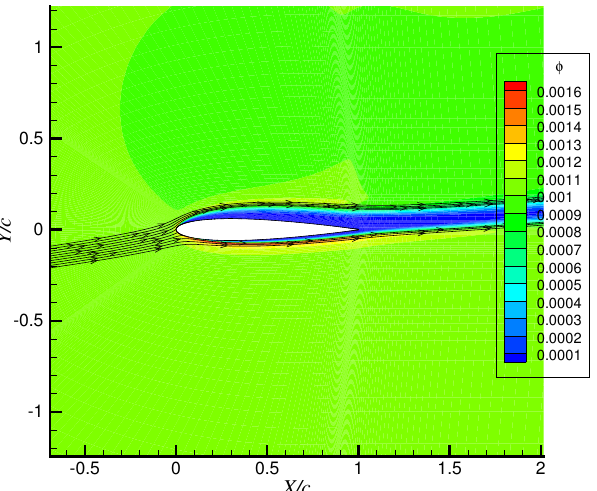
Figure 11. Liquid water content calculated by the Eulerian model and droplet trajectory by the Lagrangian